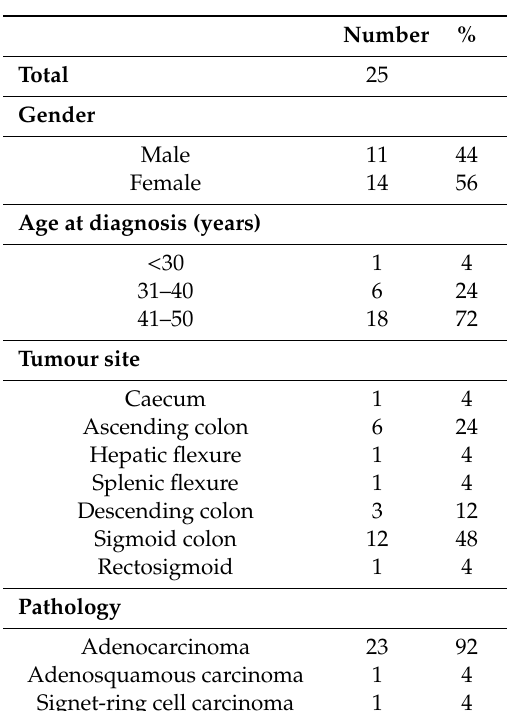
Table 1. Clinical features of the early-onset CRC